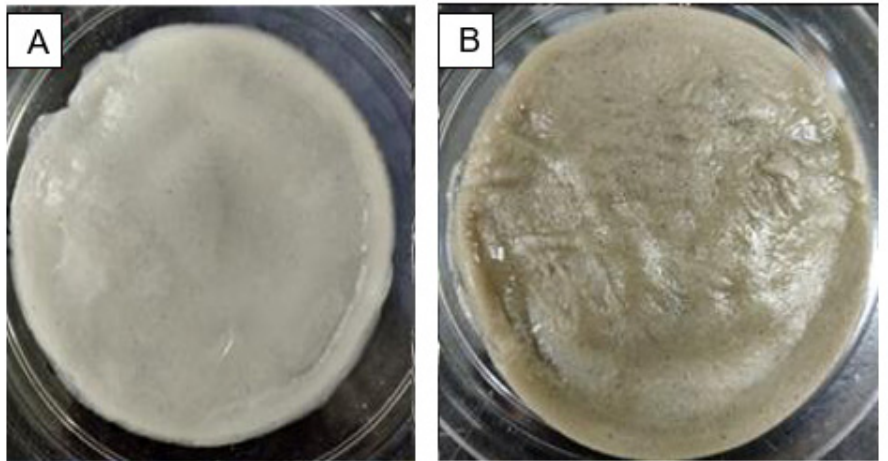
Figure 8. The formation of two types of hydrogel film in the petri dish and a comparison of the physical morphology of the CNC/Alg film ( A ) and the bioAgNP/CNC/Alg film ( B ). FTIR analysis was conducted for the bioAgNPs, the CNC/Alg hydrogel film, and the bioAgNP/CNC/Alg hydrogel film. In Figure 9A, several signature peak regions can be